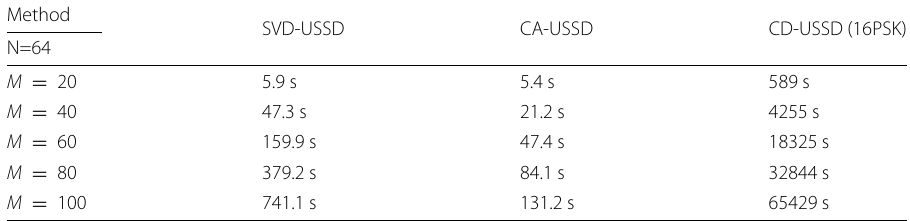
Table 4 Runtime of SVD-USSD, CA-USSD, and CD-USSD algorithms Method